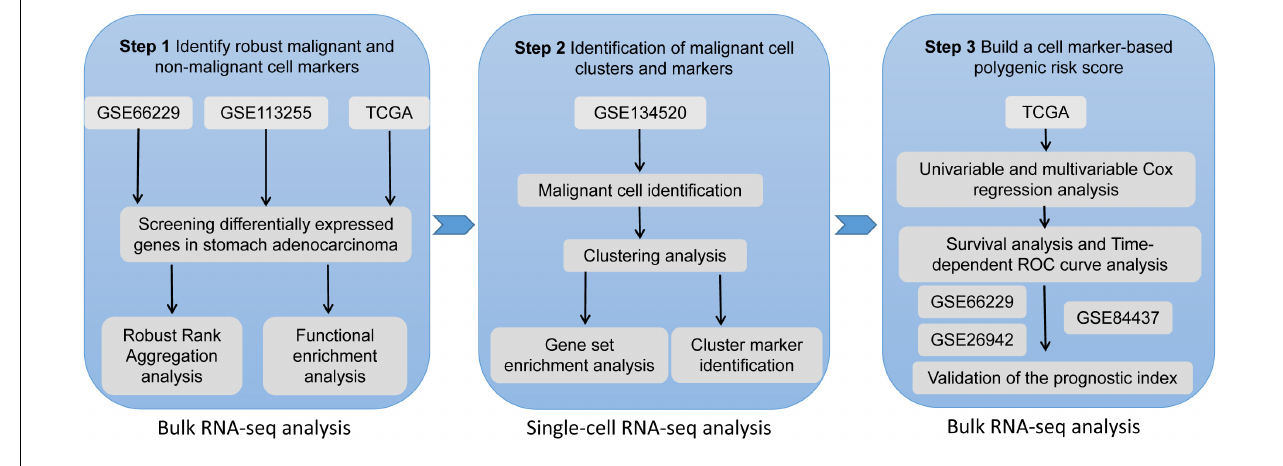
FIGURE 1 | The workflow of the present